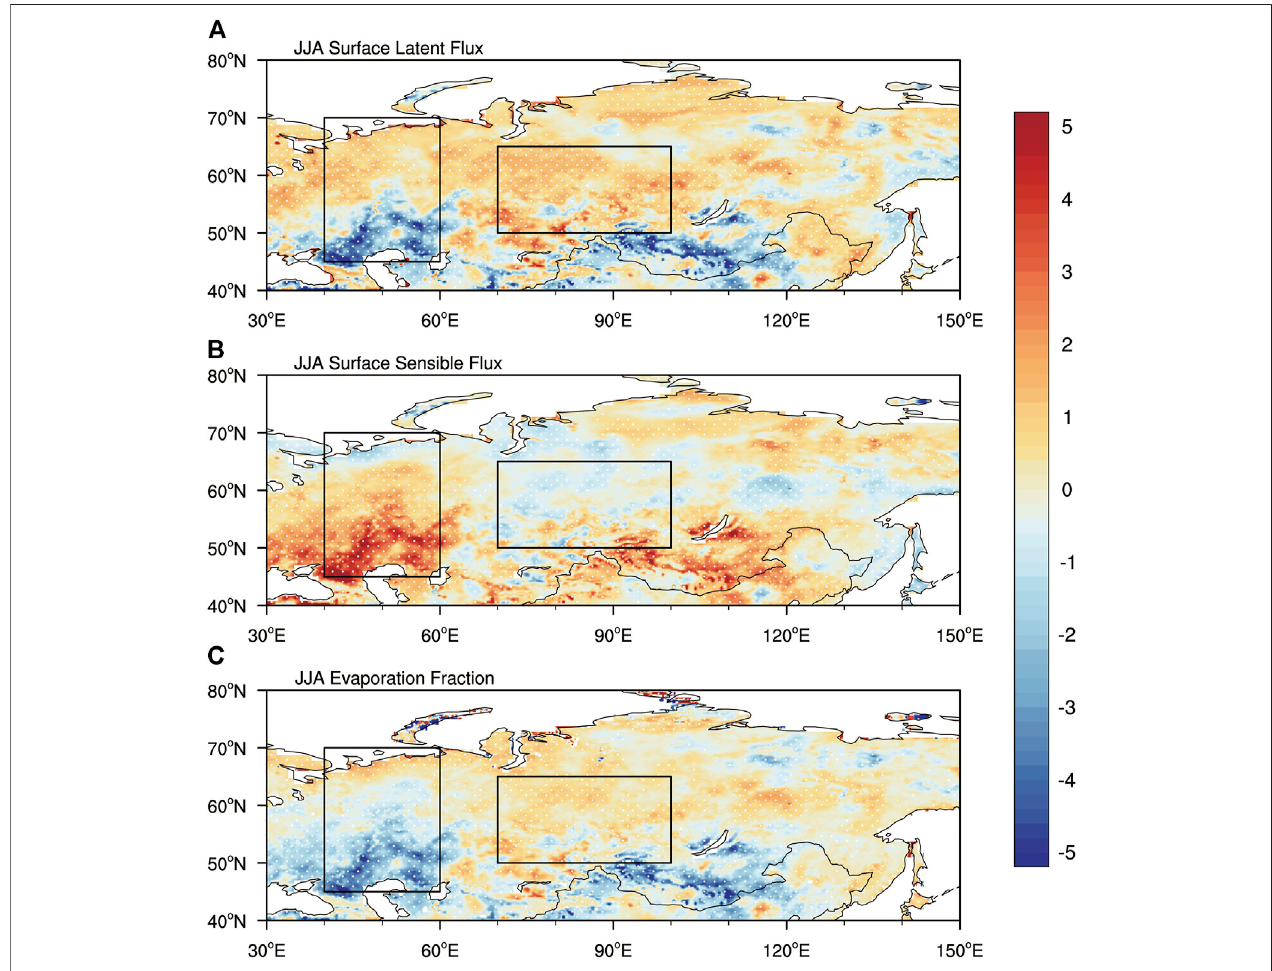
FIGURE 4 | Summer (JJA) (A) surface latent fl ux, (B) surface sensible fl ux anomalies (W m − 2 ) and (C) evaporation fraction (%) regressed onto the SSDI. The black rectangles are the same as in Figure 1A , and the stippling indicates the regression coef fi cients statistically signi fi cant at the 95% con fi dence level.